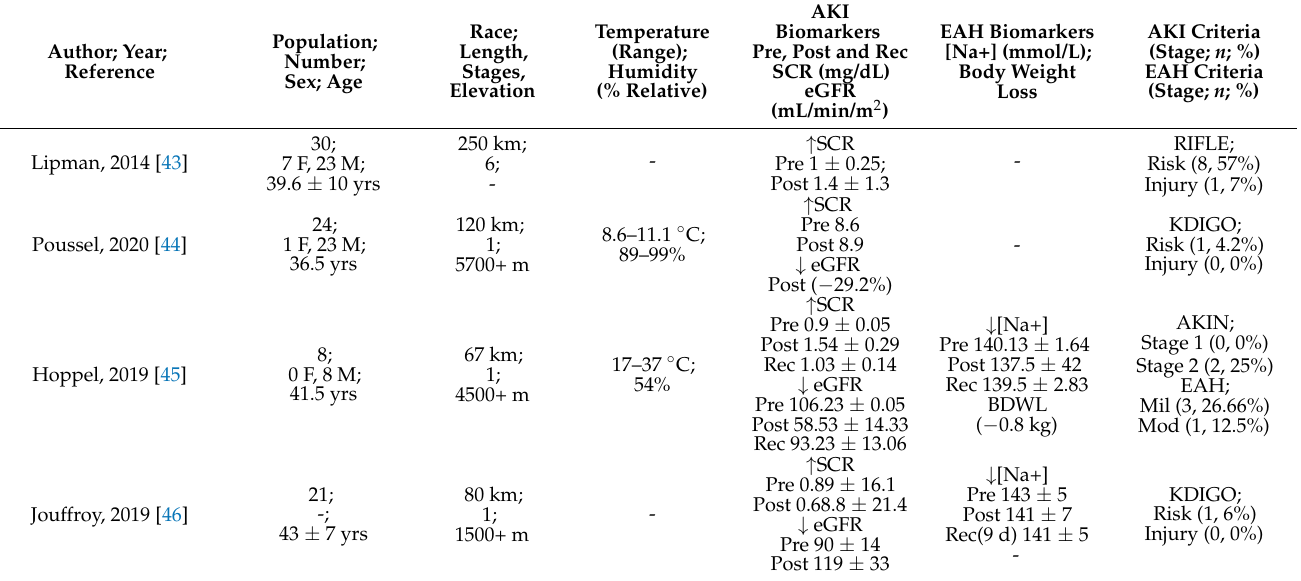
Table 1. Included studies examining AKI as a primary variable in subjects participating in ultra-trail